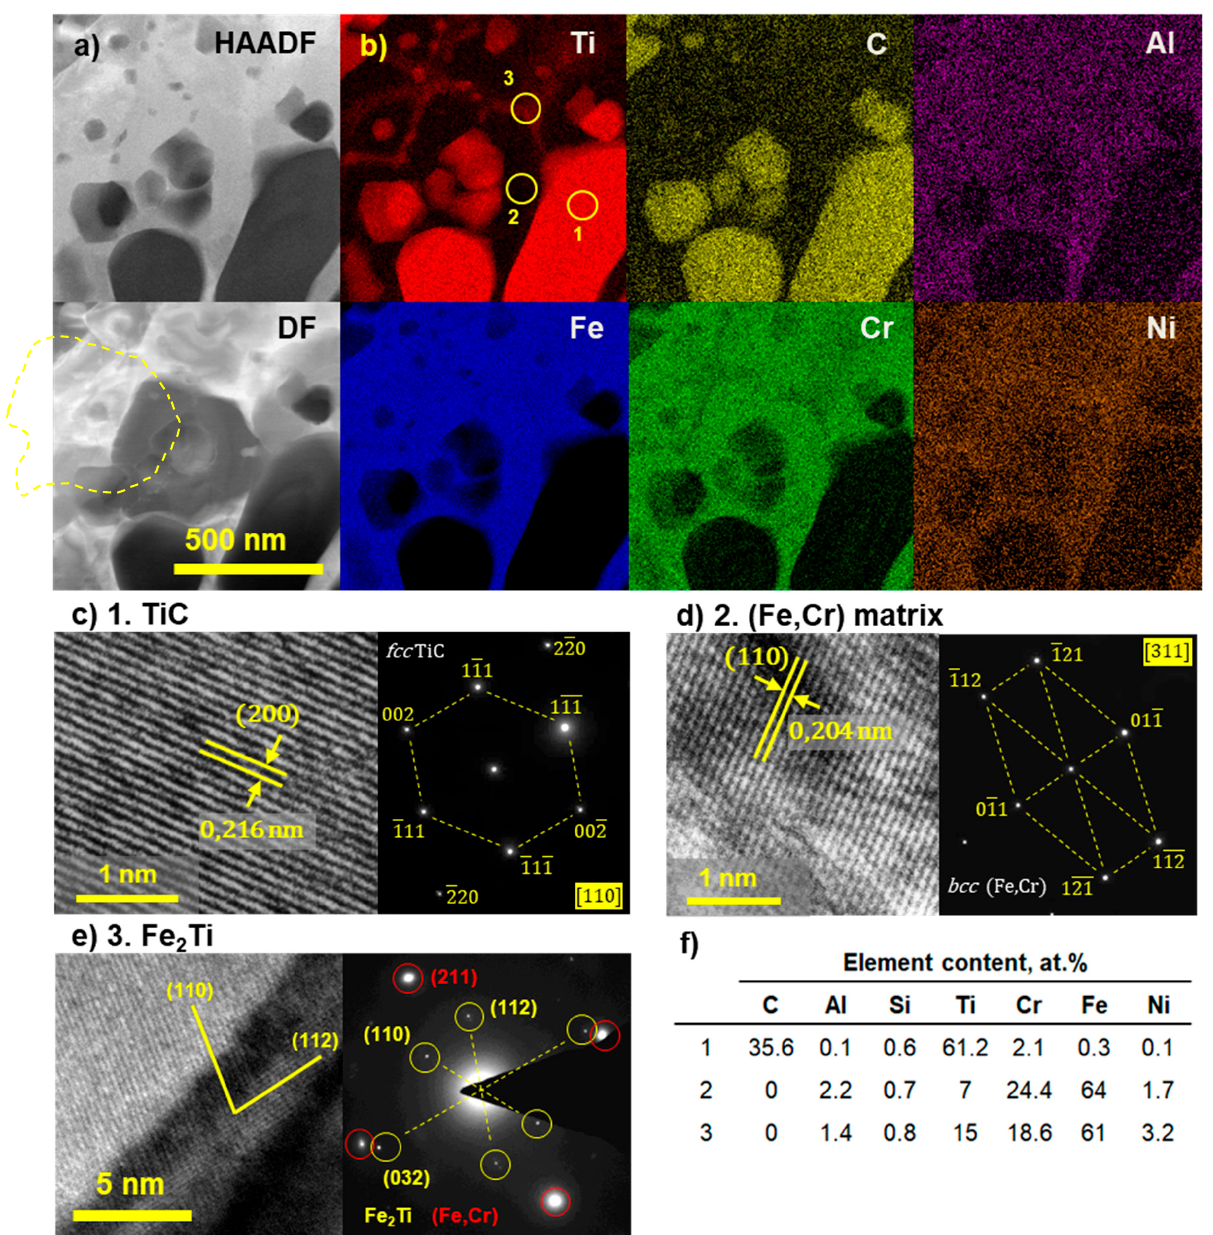
Figure 6. HAADF and DF TEM images of 75TiC coating ( a ) with EDS elemental maps ( b ) and corresponding HR TEM images, SAED patterns, and elemental composition ( f ) of marked areas 1 ( c ), 2 ( d ), and 3 ( e ).